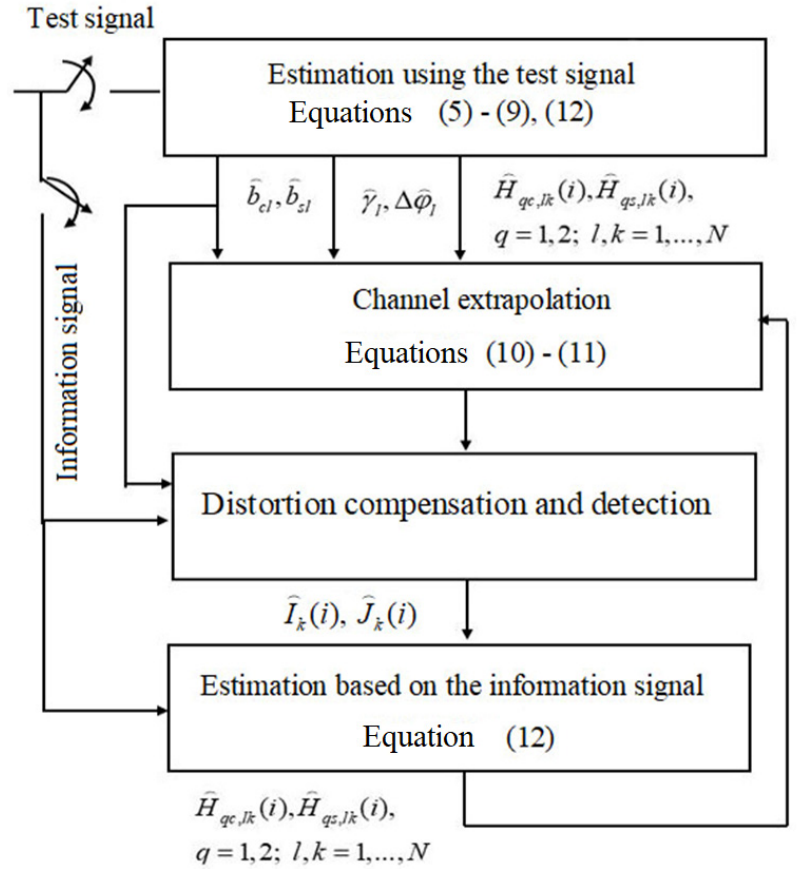
Figure 1. The structure of the signal processing algorithm in a MIMO communication system.